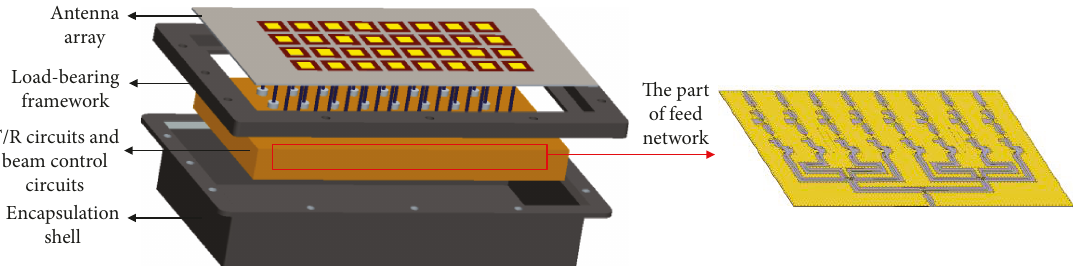
Figure 1: Structural con fi guration of the AESA